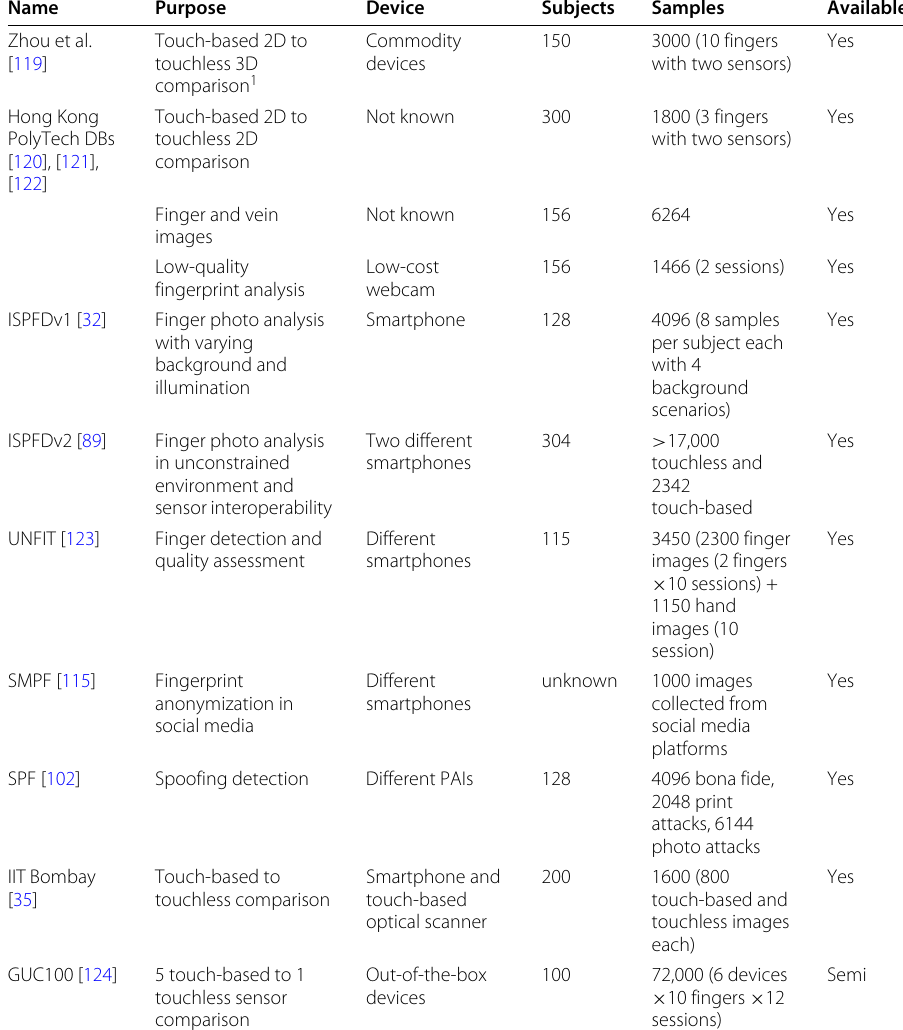
Table 5 Overview of publicly available touchless fingerprint